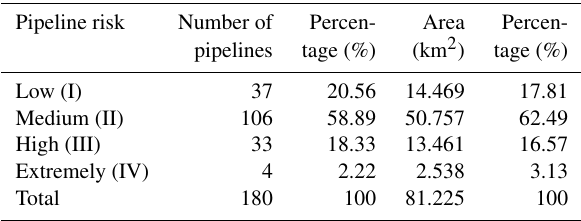
Table 5. Number and distances of pipeline of four risk grades. Pipeline